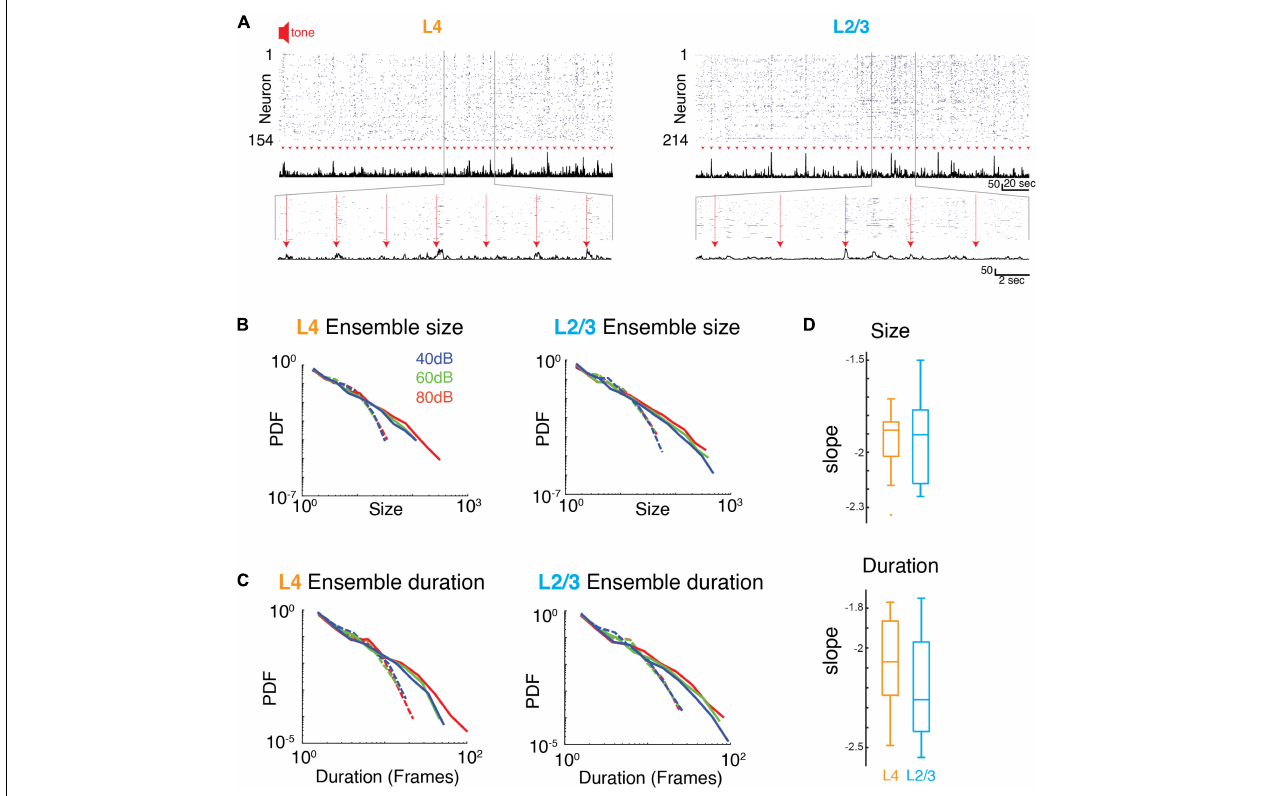
FIGURE 4 | Neuronal ensembles in A1 during ongoing activity organize as neuronal avalanches. (A) Activity raster of simultaneously recorded L4 ( left ) and L2/3 ( right ) neurons to brief auditory inputs ( arrow heads ). Middle : Corresponding population activities summed over all neurons. Bottom : Enlarged views revealing variable, transient evoked responses. (B,C) Probability density distributions of ensemble sizes and ensemble duration reveal power laws for the evoked responses and different sound intensity in L4 ( left ) and L2/3 ( right ). Dashed lines indicate probability density distributions from shuffled data sets. (D) Boxplots showing slopes of probability distributions in ensemble size ( top ) and ensemble duration ( bottom ) for each individual experiment in L4 (orange) and L2/3 (blue), Size: α L2 / 3 : –1.93 ± 0.25, α L4 : –1.95 ± 0.20, Duration: α L2 / 3 : –2.20 ± 0.26, α L4 : –2.08 ± 0.25, mean ± SD; p size > 0.84, p dur > 0.29, unpaired two-sample t